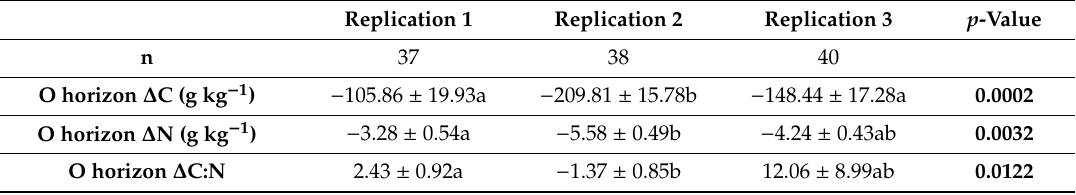
Table 2. Mean di ff erences in 2001 and 2018 ( ± mean standard error) O horizon and mineral soil variables for treatment replications on the Green River Game Lands near Asheville, NC, USA. Significant di ff erence determination for mean ∆ values are bolded ( α = 0.05) and Tukey’s HSD di ff erences between replications (across rows) are noted by letter